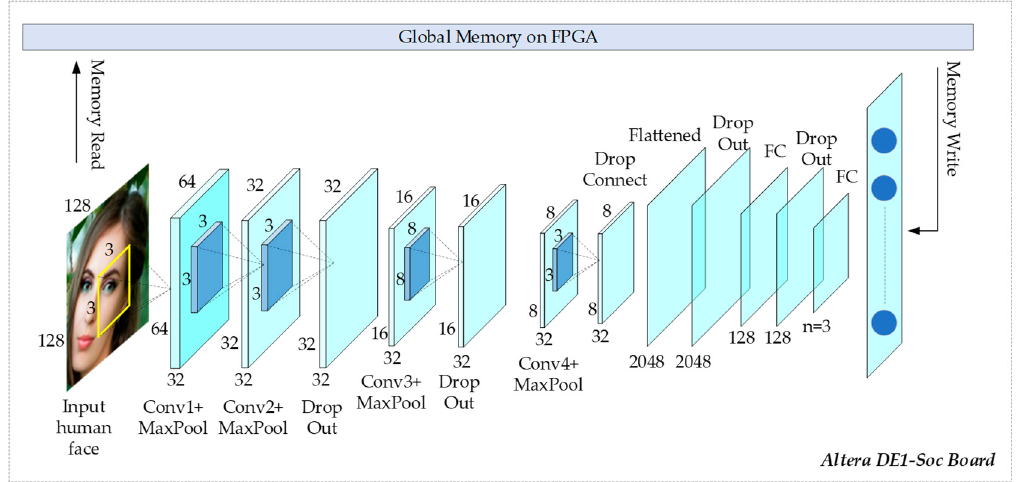
Figure 3. Our proposal system for ethnicity identification based on deep learning.